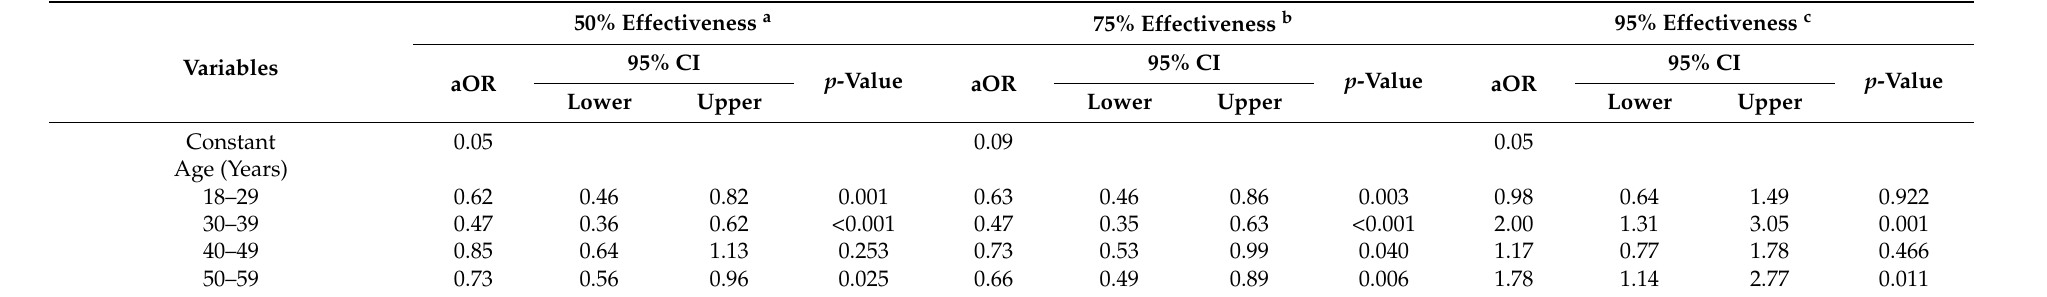
Table 4. Multiple logistic regression models of factors predicting vaccine acceptance for child at 50%, 75%, and 95% effectiveness